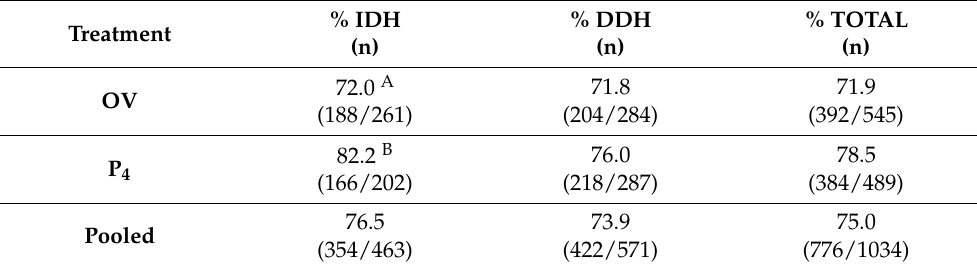
Table 3. Descriptive statistics on the efficiency of re-synchronization and reported pregnancies, over season (column) and re-synchronization protocols (rows) in primiparous buffaloes synchronized by Ovsynch (OV) or Progesterone based treatment (P 4 ) and that underwent AI during periods characterized by Increasing Daylight Hours (IDH) and Decreasing Daylight Hours (DDH). Last column and last row report the pooled seasons and the pooled treatments, respectively.